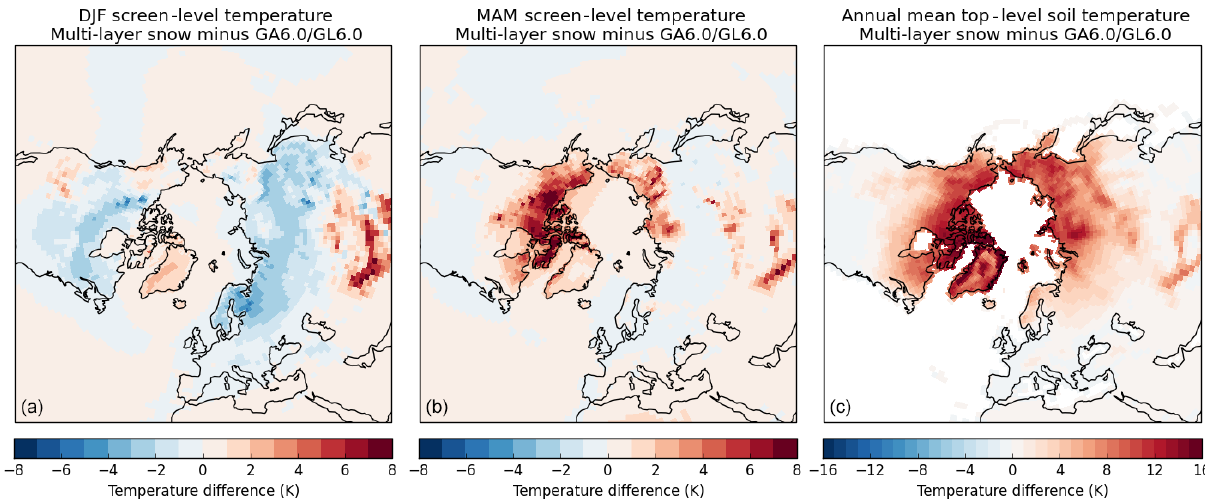
Figure 9. The difference in mean DJF screen-level temperature (a) , mean MAM screen-level temperature, (b) and annual mean topmost level soil temperature (c) from a 20-year N96 atmosphere/land-only climate simulation with and without GL7’s multi-layer snow scheme. The baseline simulation is